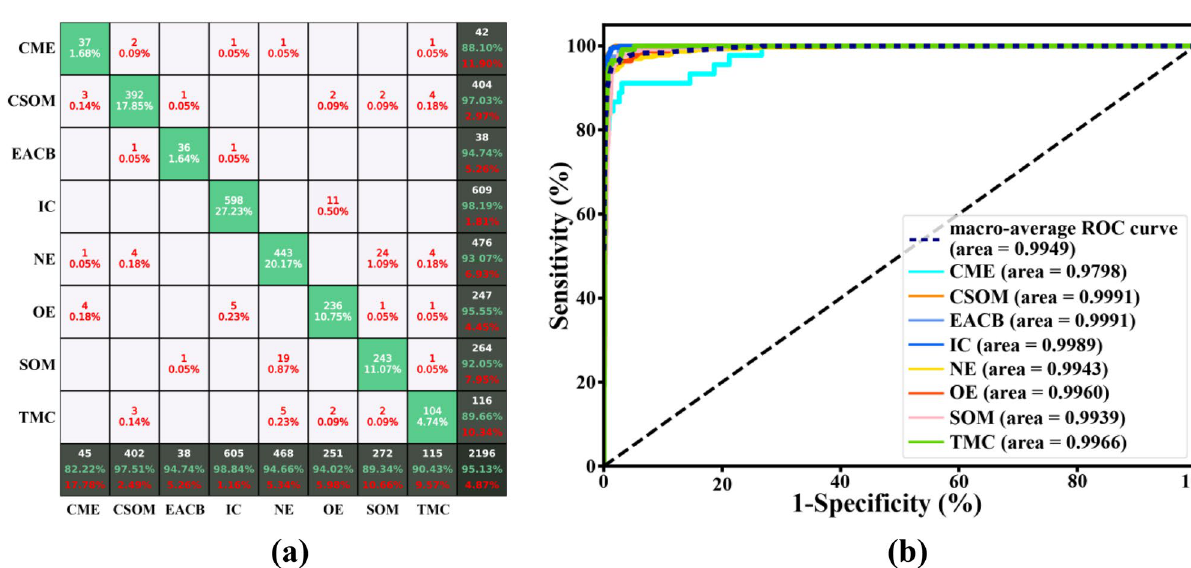
Figure 10. The Confusion matrices ( a ) and sensitivity–specificity ( b ) curve of the real-time automatic identification system based on the ensemble classifier at endoscopic images about the past six